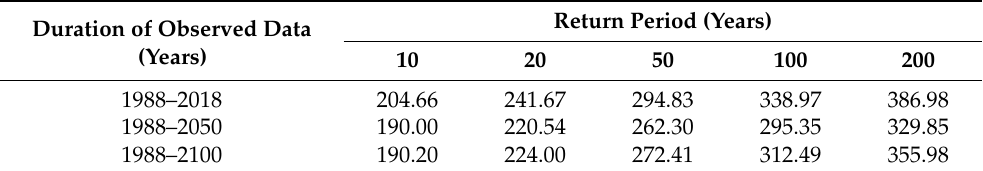
Table 8. Probable annual maximum daily rainfall at Gimhae rainfall station using RCP 4.5 scenario (unit: mm/day).